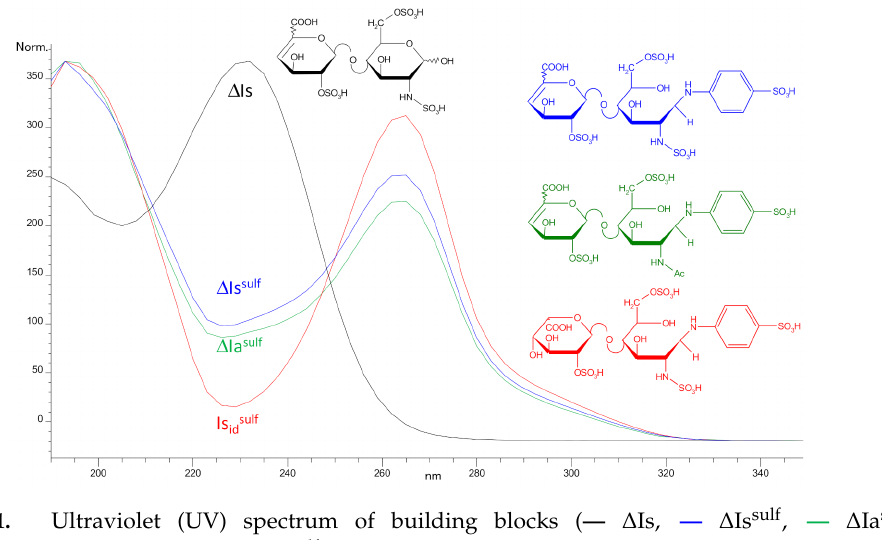
Figure 1. Ultraviolet (UV) spectrum of building blocks ( — ∆ Is, — ∆ Is sulf , — ∆ Ia sulf ( ∆ HexUA(2S)-GlcNAc(6S)-SA), — Is idsulf ).